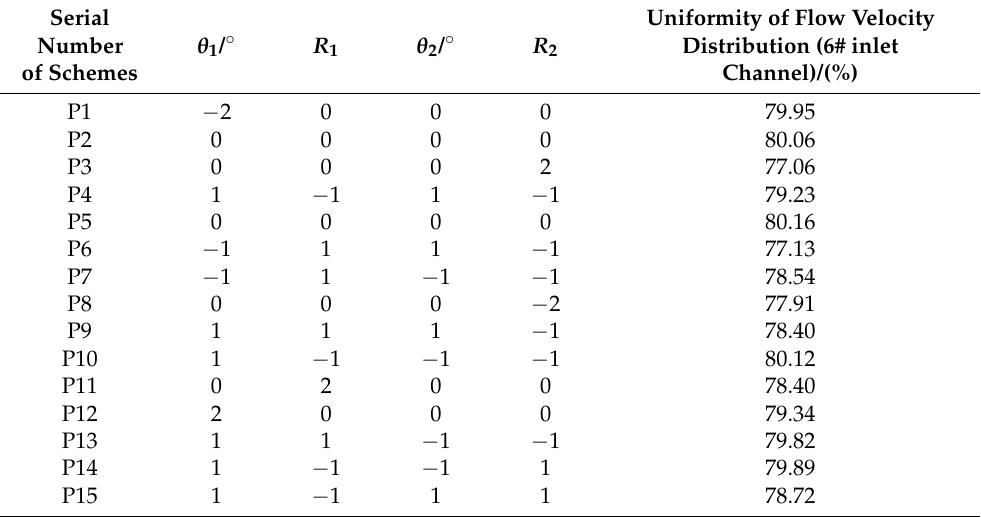
Table 3. Results of indicators of the schemes in the CCD-Response Surface Method under the operational state of